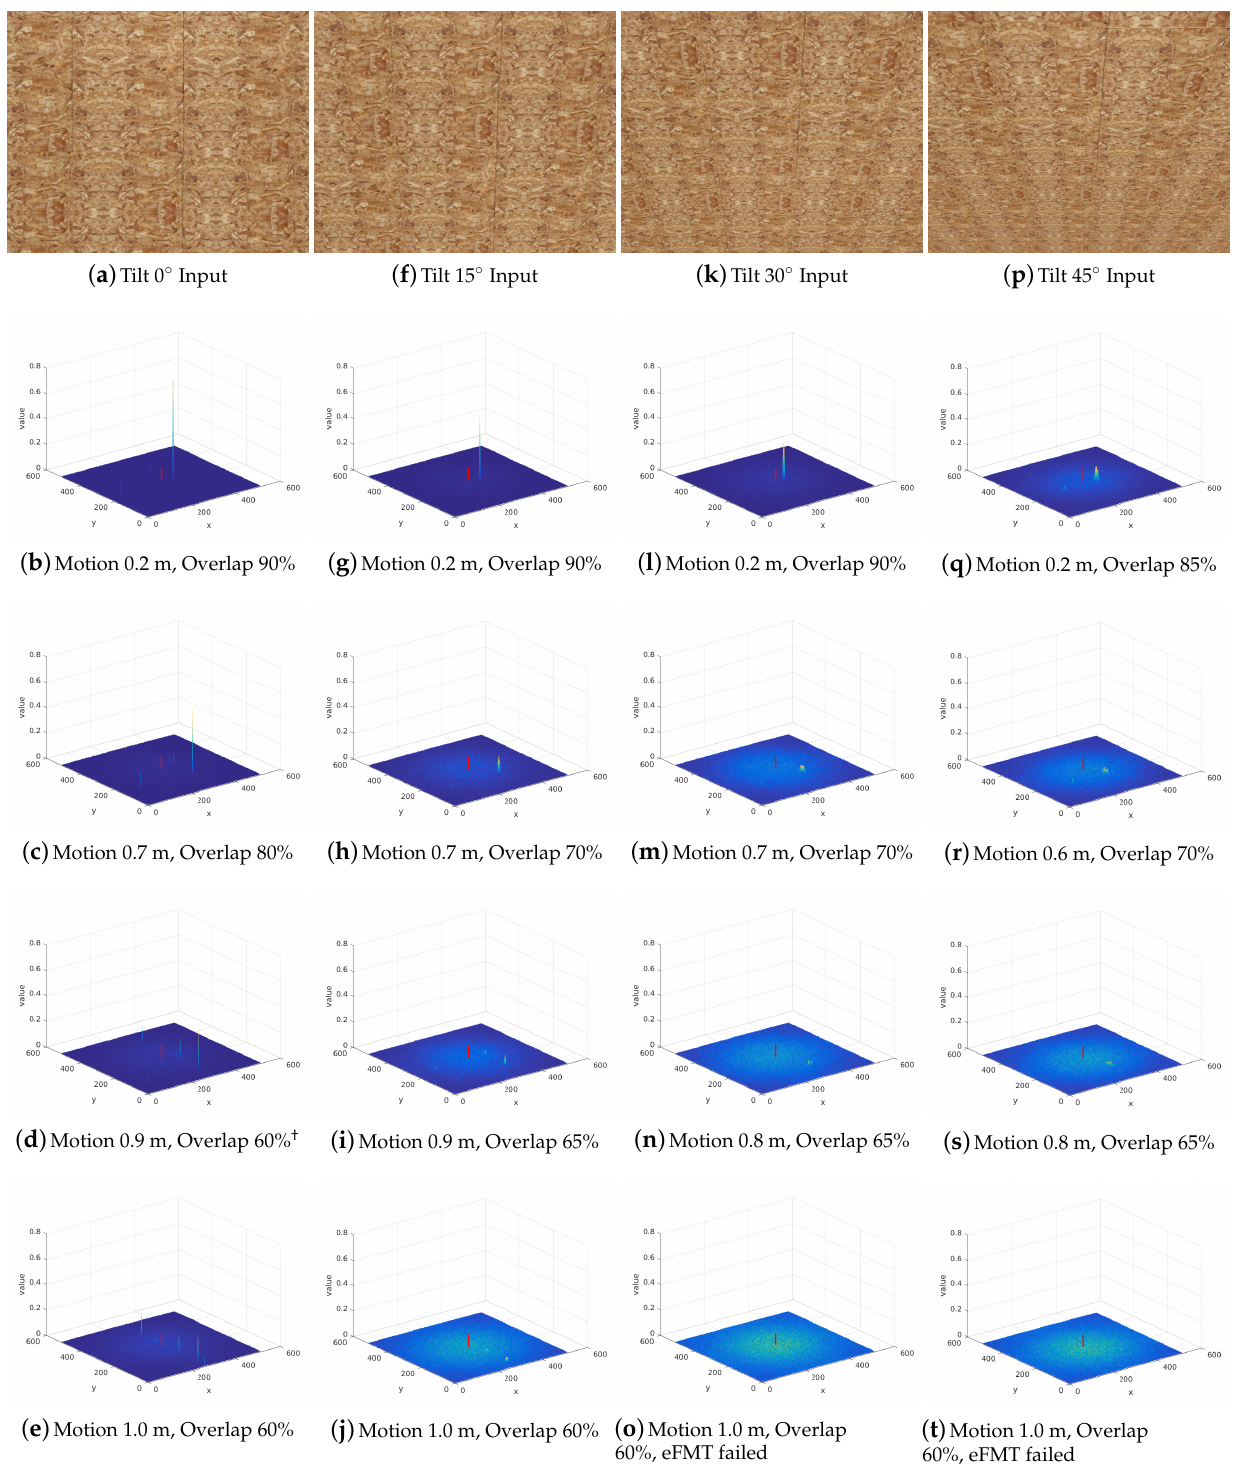
Figure 16. Translation PSDs with different tilt angles and camera motions. The angle between the plane and the imaging plane changes from 0 ◦ to 45 ◦ . Each column corresponds to one angle. When the angle is not 0 ◦ , it is a slanted plane in the view, leading to continuous depths. The distance between the camera and the slanted plane is about 3 m. † The overlap is smaller than others in this row due to the bigger motion in u -direction of the